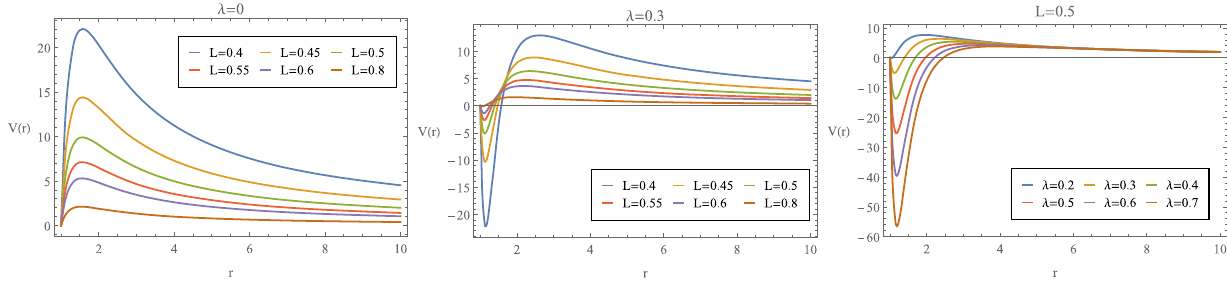
Fig. 3 The effective potential in asymptotical AdS black hole with positive curvature